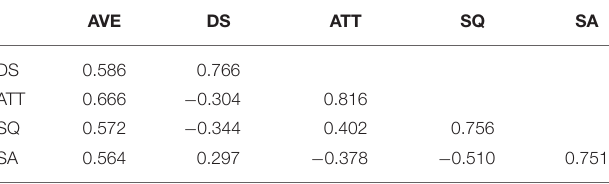
TABLE 5 | Discriminant validity for the measurement model. TABLE 6 | Model fit.